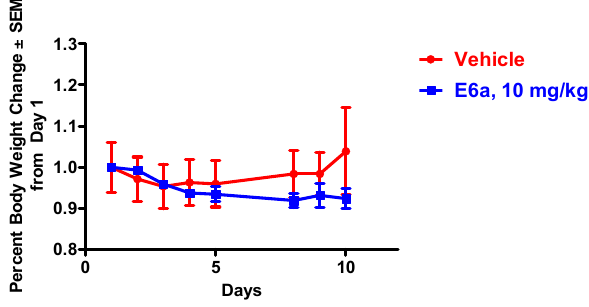
Figure 7. The effect of BiQ-1 in female Swiss Webster mice. BiQ-1 was dosed daily for 5 days, two days off and then continued for 3 more days. Mean body weight loss did not exceed 10%. Three mice were included per group.